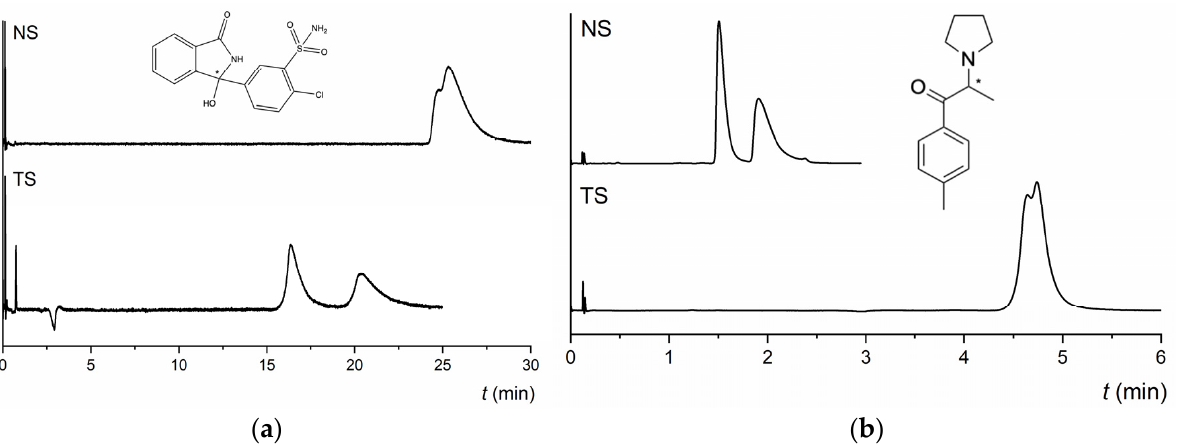
Figure 1. The overall success rate of baseline and partial enantioseparations for individual groups of basic biologically active compounds in different MPs; A—derivatives of pyrovalerone, B—derivatives of cathinones, C—derivatives of ketamines, D—others. Partial enantioseparation: α ≥ 1.1; baseline enantioseparation: R ≥ 1.5.